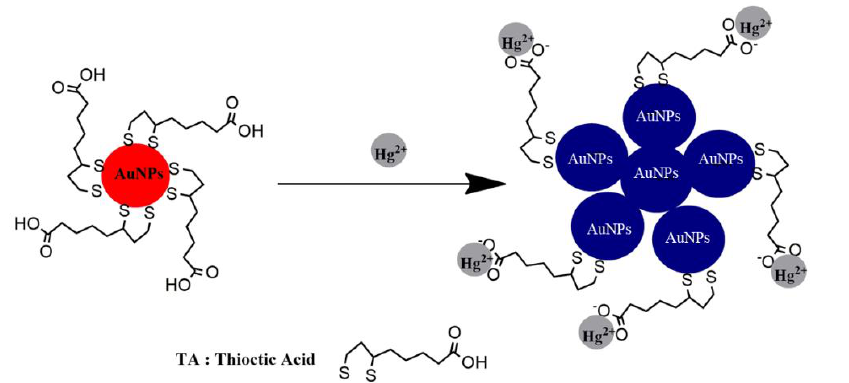
Fig. 5. Proposed mechanism for Hg 2+ detection using TA@AuNPs colorimetry